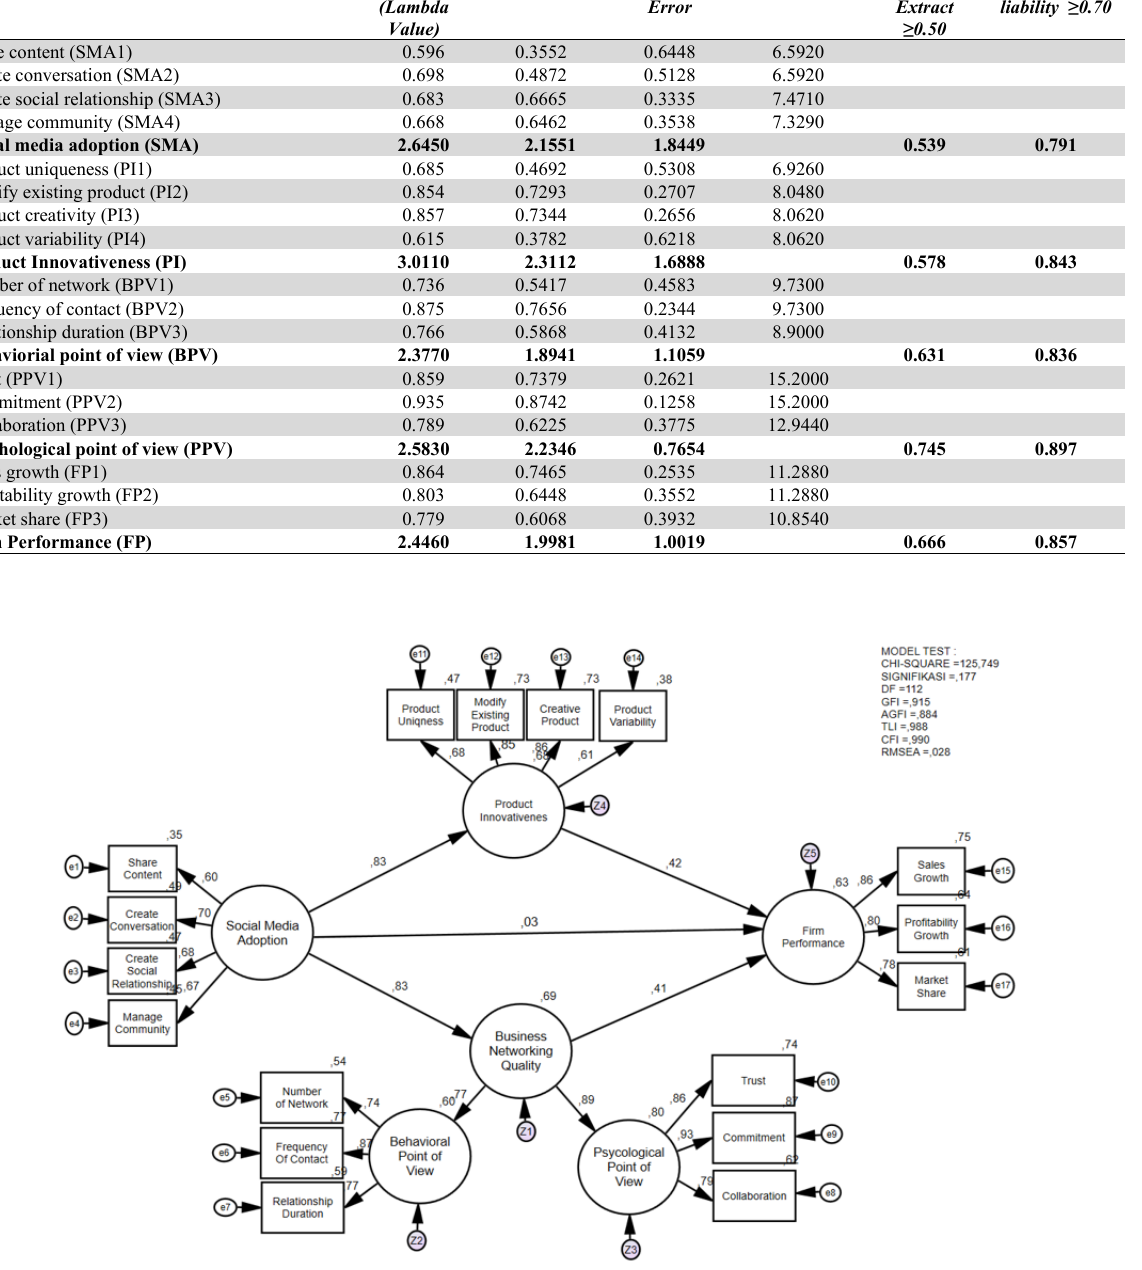
Fig. 1. Full Structural Model: Business Networking